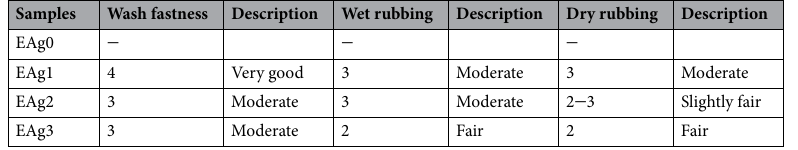
Table 13. Fastness characteristics for control and nanosilver-coated sisal/cotton interwoven fabrics.